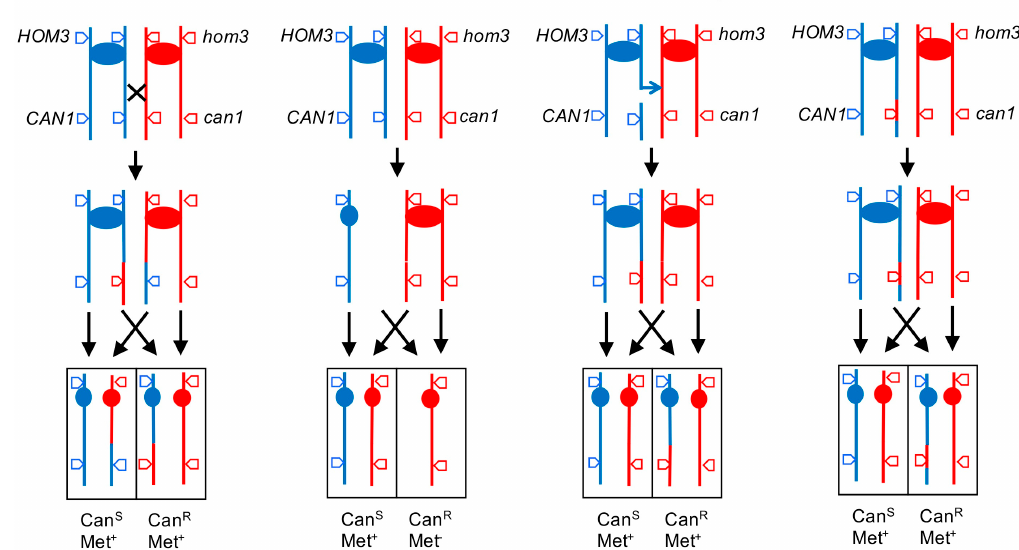
Figure 1. Mechanisms leading to loss of heterozygosity (LOH) in a diploid that is heterozygous for a can1 mutation. A commonly used assay in yeast to detect LOH involves a diploid that is heterozygous for can1 and hom3 mutations located on chromosome V. Strains that are heterozygous for the can1 mutation are sensitive to canavanine, and strains heterozygous for the hom3 mutation can grow in medium lacking methionine. The different line colors represent the two homologs, and the ovals show the centromeres. The events are depicted as occurring in cells after replication. ( A ) Mitotic crossover. A crossover between the can1 marker and the centromere can result in one cell that is homozygous of the can1 allele and another cell homozygous for the wild-type CAN1 allele. Both strains remain heterozygous for the hom3 allele. In the figure, we show the chromosome segregation pattern that results in LOH (indicated by four arrows). An equally frequent segregation pattern in which the recombinant chromatids segregate together will not result in LOH. ( B ) Chromosome loss. Loss of one of the blue chromatids results in one Can R product that is also Met - ; the other product is identical to the original diploid. ( C ) Break-induced replication. In this mechanism, one blue chromatid is broken, and the acentric fragment is lost. The centromere-containing broken chromatid invades one of the red chromatids, copying its sequences from the point of invasion to the end. The Can R cell has the same phenotype as that produced by a crossover, but the event is non-reciprocal, and the other product is identical to the original diploid. ( D ) Gene conversion. A break in the blue chromatid is repaired using an internal segment of the red chromatid. This mechanism results in an interstitial LOH region.